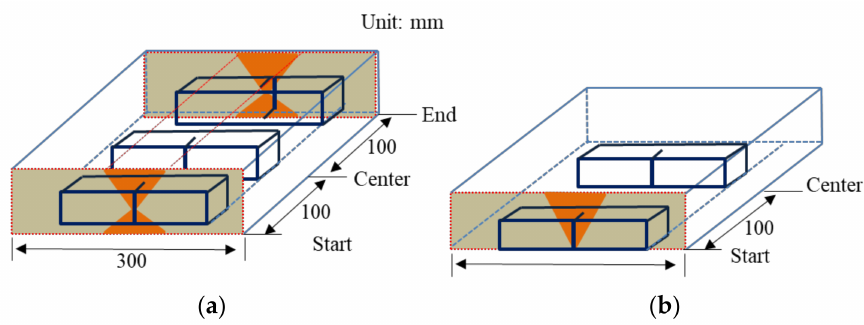
Figure 4. Position of specimens in impact test: ( a ) SAW (B1–B4) and ( b ) FCAW (B5).